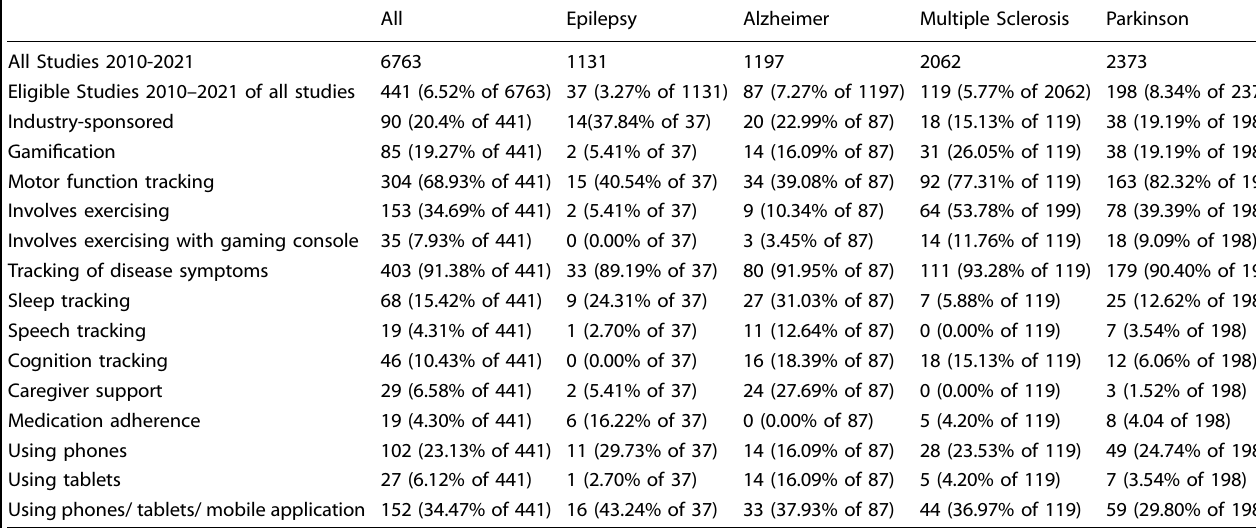
Table 1. Qualitative (categorical) features of trials by